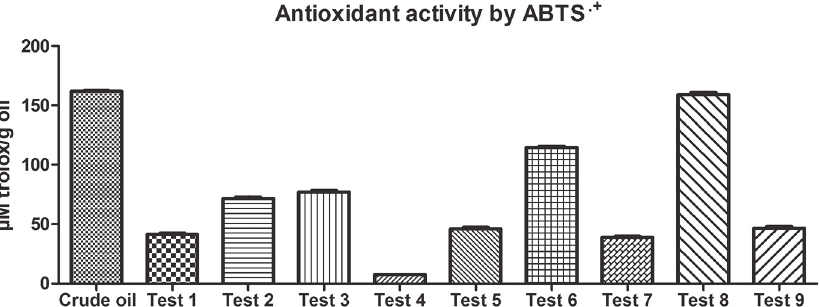
FIGURE 5 - Antioxidant activity of Attalea phalerata Mart. pulp oil (crude and microcapsules) by ABTS •+ method, obtained by complex coacervation at different process conditions. Means of tests performed in triplicate. Test 1 (5 g, 40 °C, 12000 rpm), test 2 (10 g, 40 °C, 12000 rpm), test 3 (5 g, 60 °C, 12000 rpm), test 4 (10 g, 60 °C, 12000 rpm), test 5 (5 g, 40 °C, 18000 rpm), test 6 (10 g, 40 °C, 18000 rpm), test 7 (5 g, 60 °C, 18000 rpm), test 8 (10 g, 60 °C, 18000 rpm) and test 9 (7.5 g, 50 °C, 18000